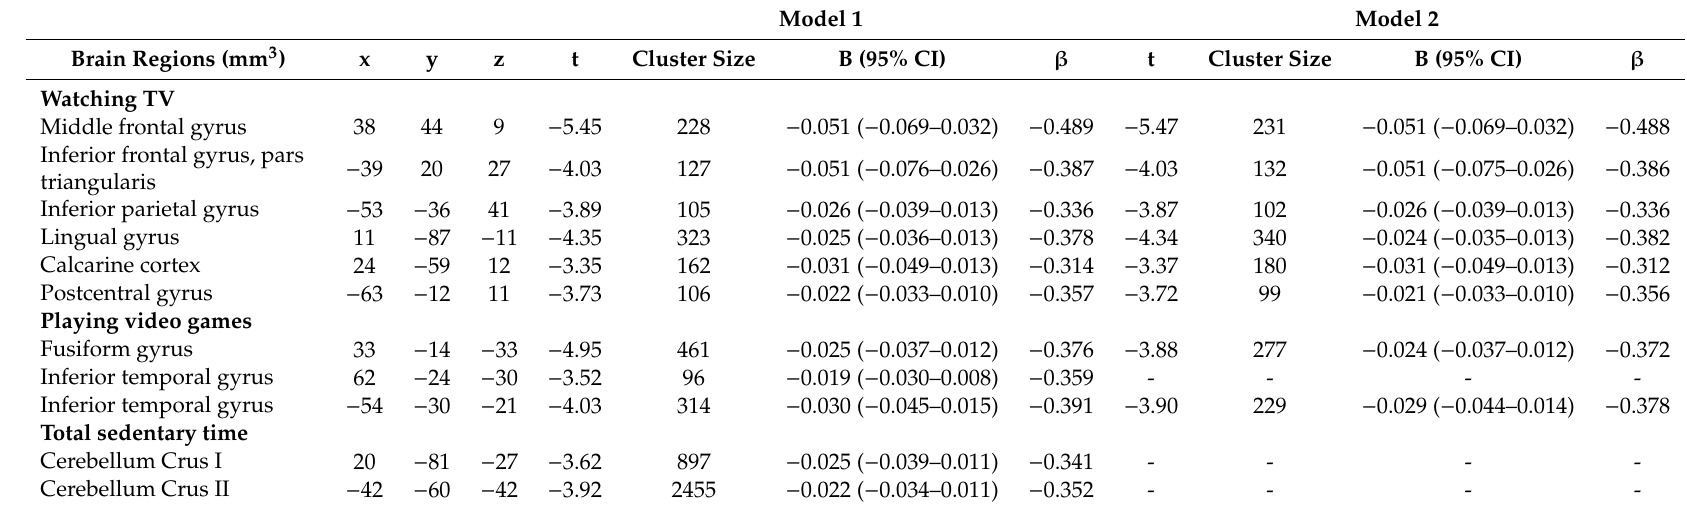
Table 2. Brain regions showing negative associations between sedentary behaviors and gray matter volume in overweight / obese children ( n =